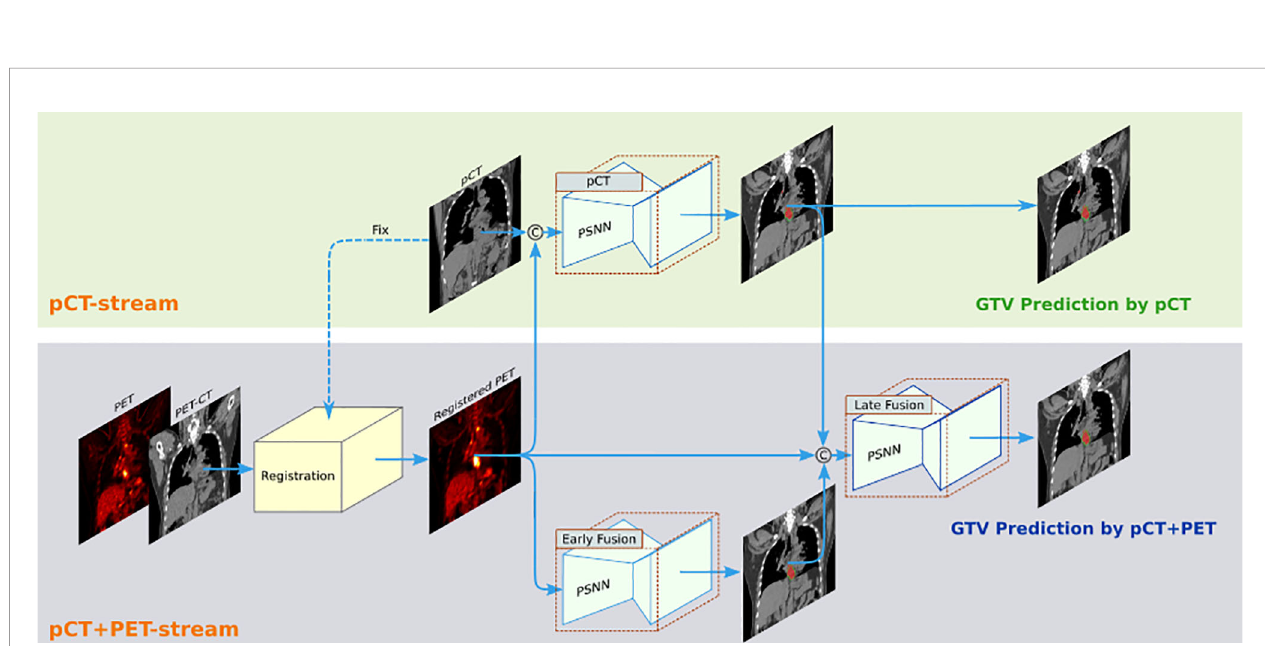
FIGURE 2 | The two-streamed 3D deep learning model for esophageal gross tumor volume (GTV) segmentation using treatment planning CT (pCT) and FDG-PET/ CT scans. pCT stream takes the pCT as input and produces the GTV segmentation prediction. The pCT+PET stream takes both pCT and PET/CT scans as input. It fi rst aligns the PET to pCT by registering diagnostic CT (accompanying PET scan) to pCT and applying the deformation fi eld to further map PET to pCT. Then, it uses an early fusion module followed by a late fusion module to segment the esophageal GTV using the complementary information in pCT and PET. This work fl ow can accommodate to the availability of PET scans in different institutions. Although 3D inputs are used, we depict 2D images for clarity.